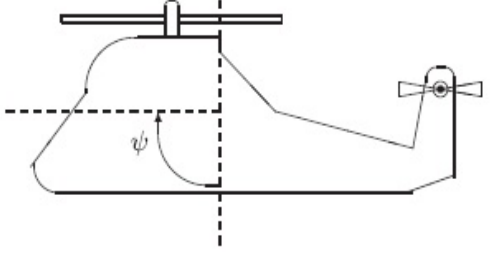
Figure 1. CE151 Helicopter